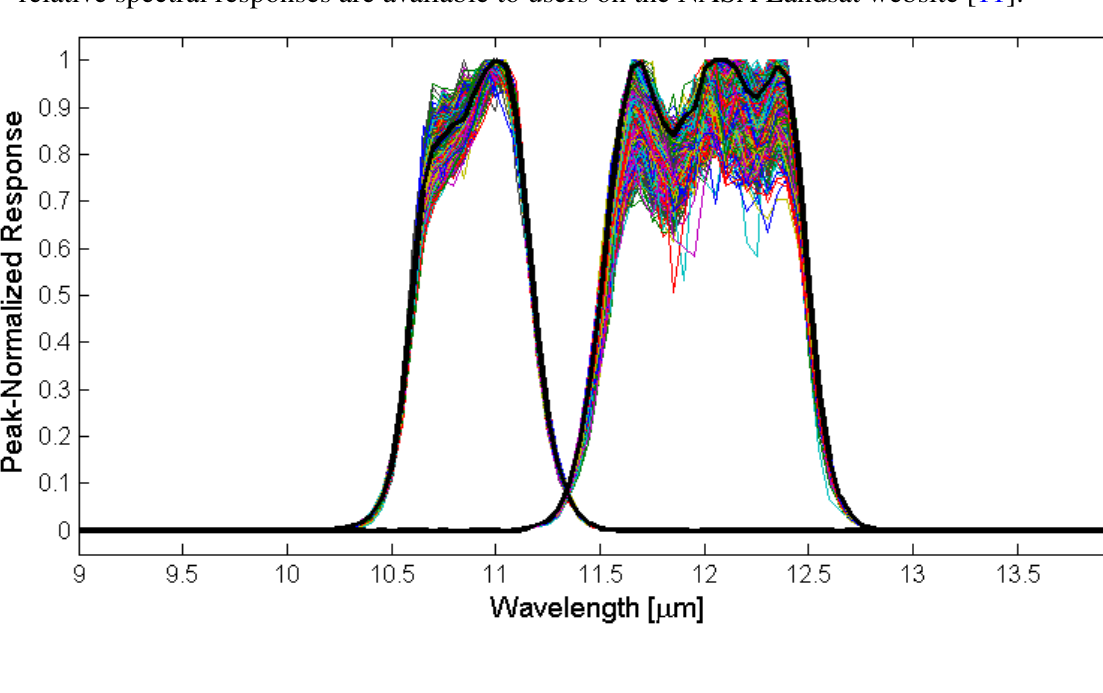
Figure 7. Relative spectral responses of all detectors that make up the primary and redundant science rows in the final TIRS image product. The black curves indicate the band average relative responses used in the radiometric calibration process. Data values for the band relative spectral responses are available to users on the NASA Landsat website